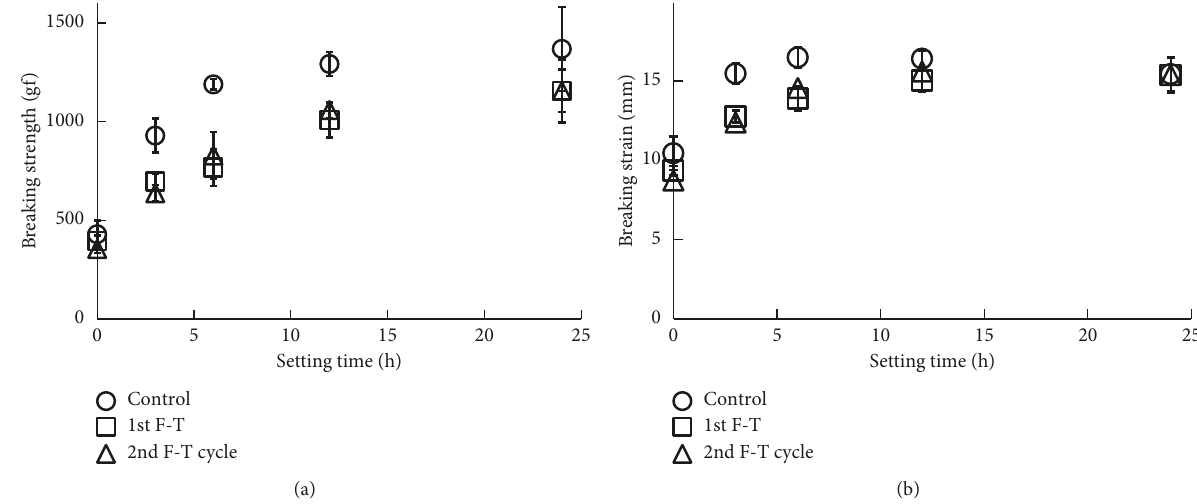
Figure 4: Changes in breaking strength and breaking strain of direct and/or two-step heated gel prepared from each frozen surimi during the setting time at 20 ° C. Error bar indicates standard deviation.